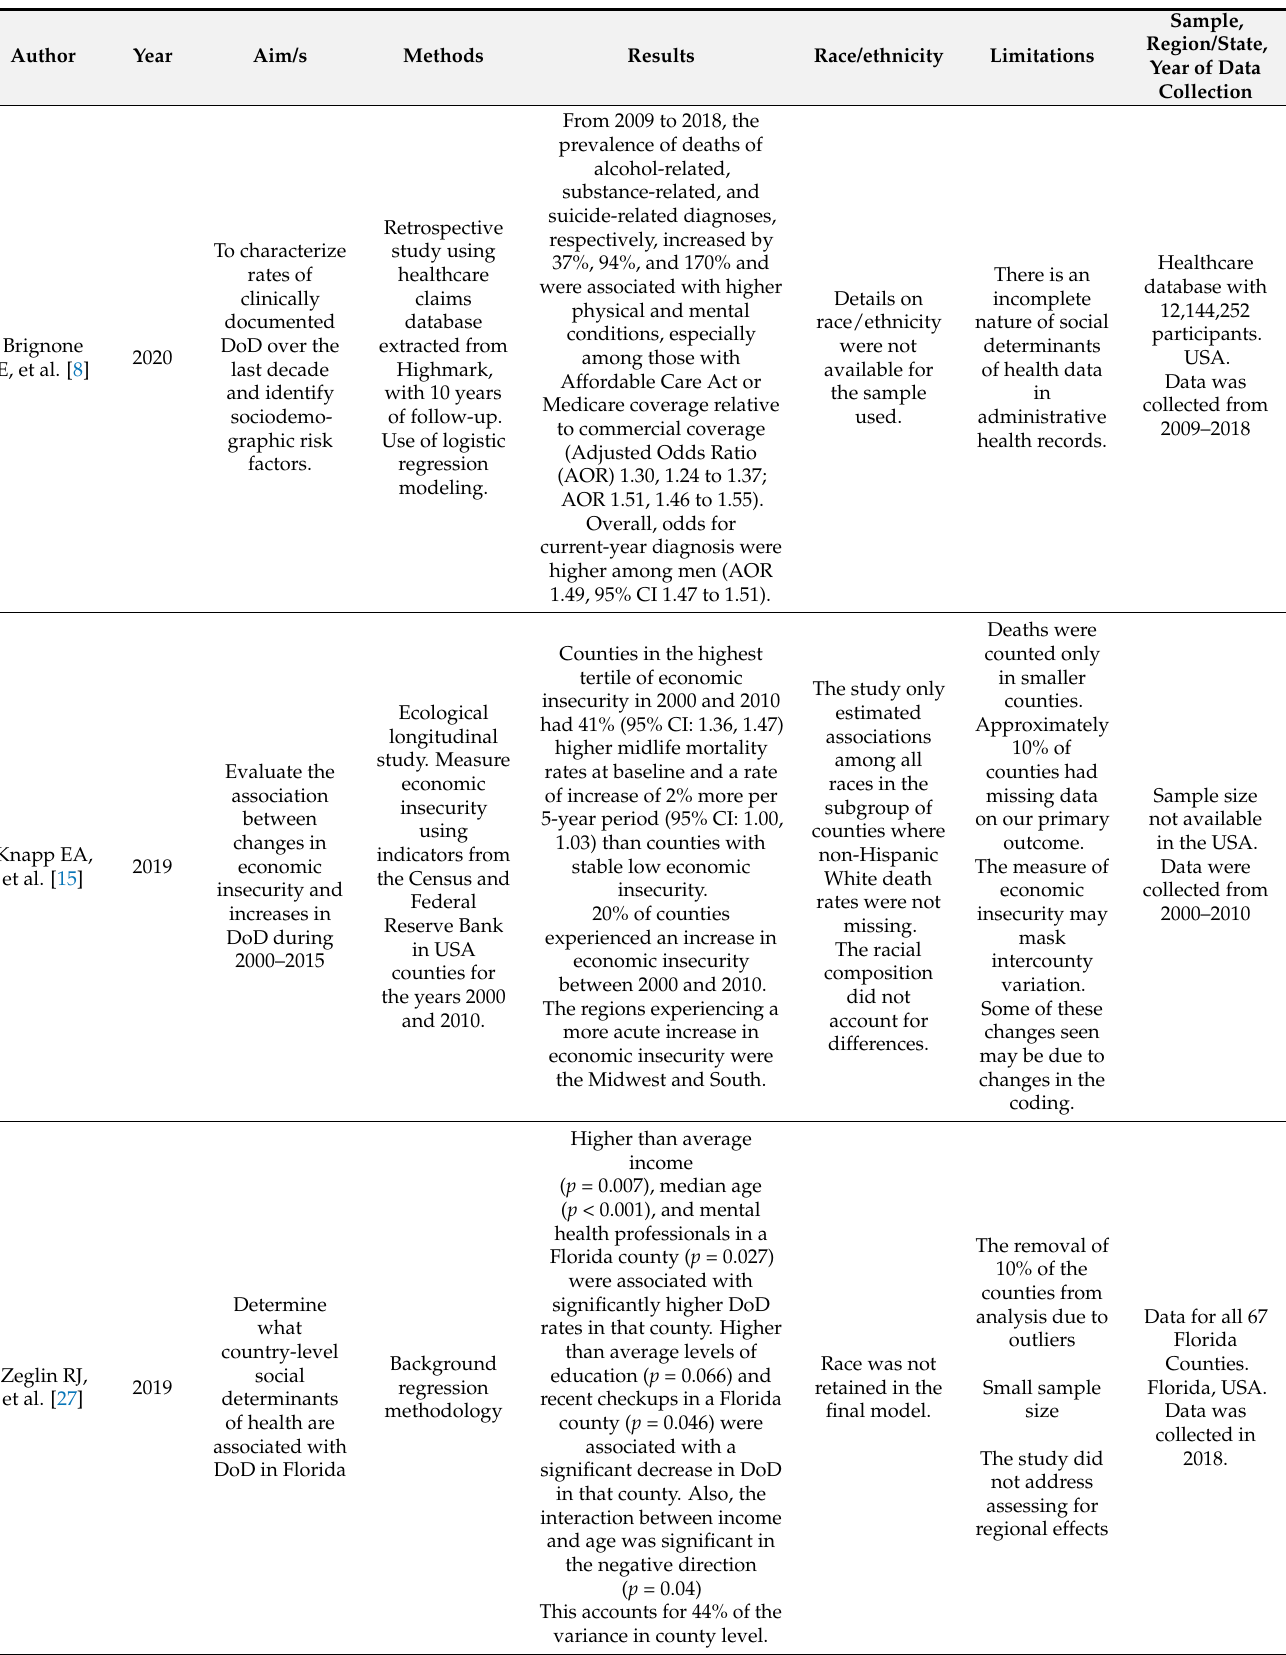
Table 1. Studies addressing Deaths of Despair according to economic